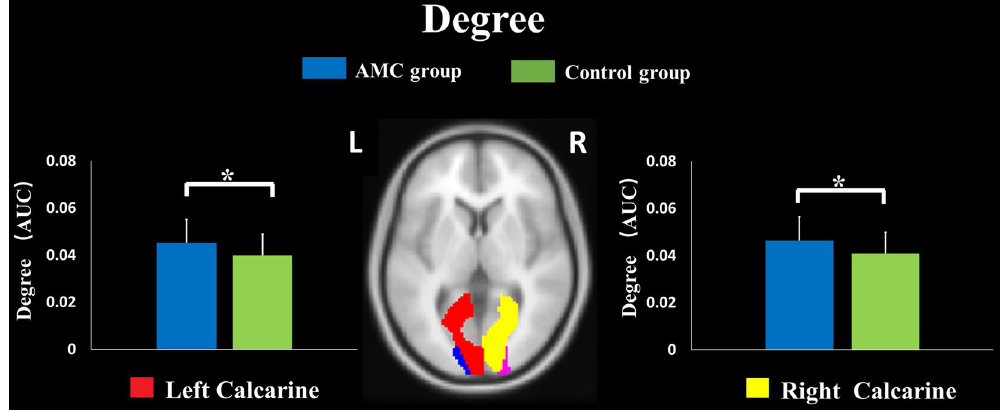
Figure 4. Group differences in nodal degree, bilateral calcarine sulcus. * p corrected < 0.05. L: left, R: right.